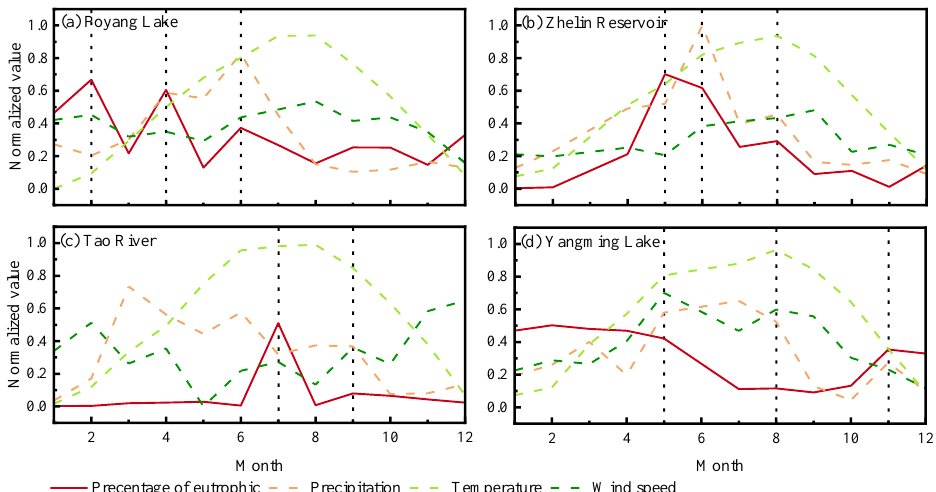
Figure 10. Monthly mean change of the proportion of eutrophic water bodies and three meteorological factors.